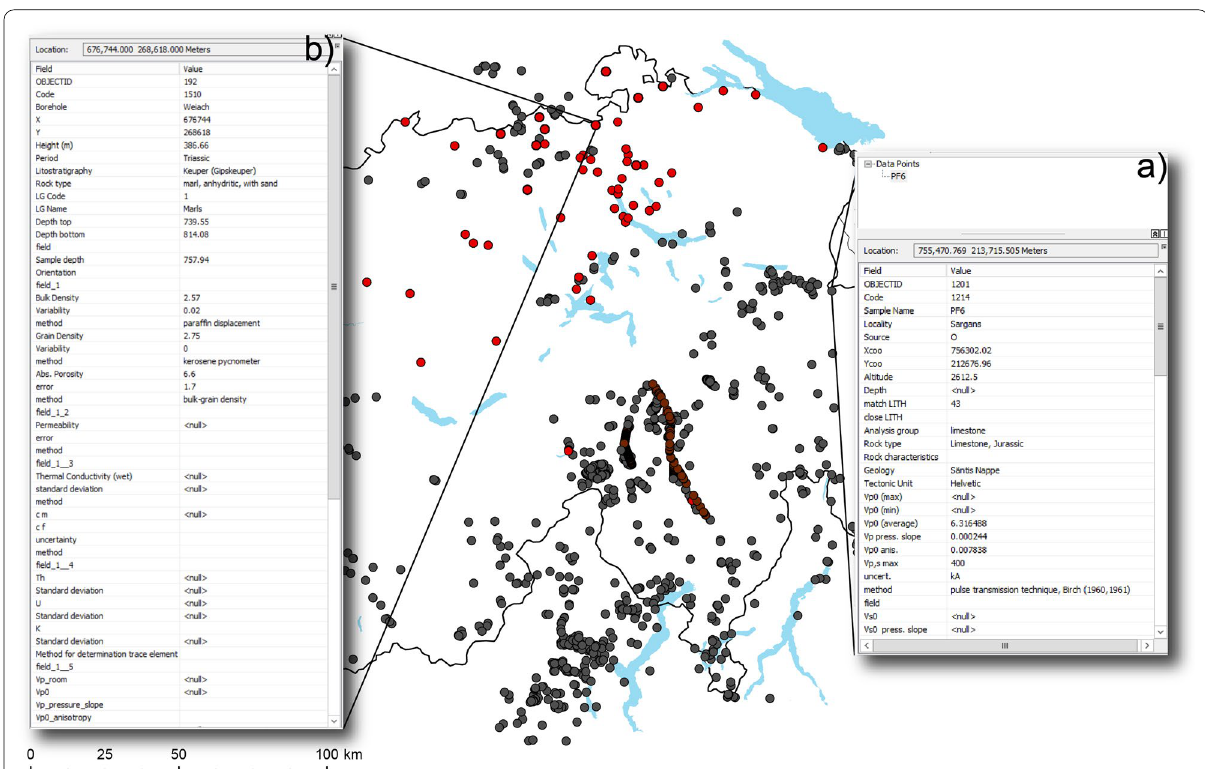
Fig. 10 Two examples of visualization of complementary data in the dbase, a for a sample from an outcrop and b from a borehole